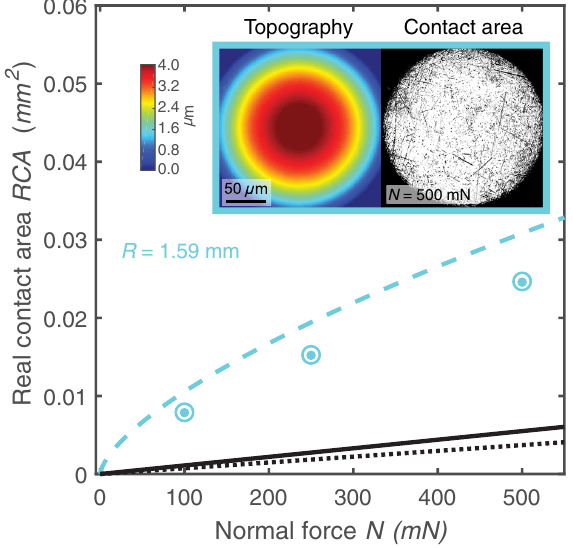
FIG. 10. Contact mechanics of a sapphire sphere (radius of 1.59 mm) sliding on ice and RCA as a function of the normal force N at temperatures of − 50 °C (open circles) and − 90 °C (closed circles). The dashed line represents the elastic Hertzian pressure, and the solid and dotted lines are, respectively, the plastic limit set by the penetration hardness at temperatures of − 50 °C and − 90 °C. Inset: surface topography (left) and calcu- lated area of real contact (right) for the sapphire